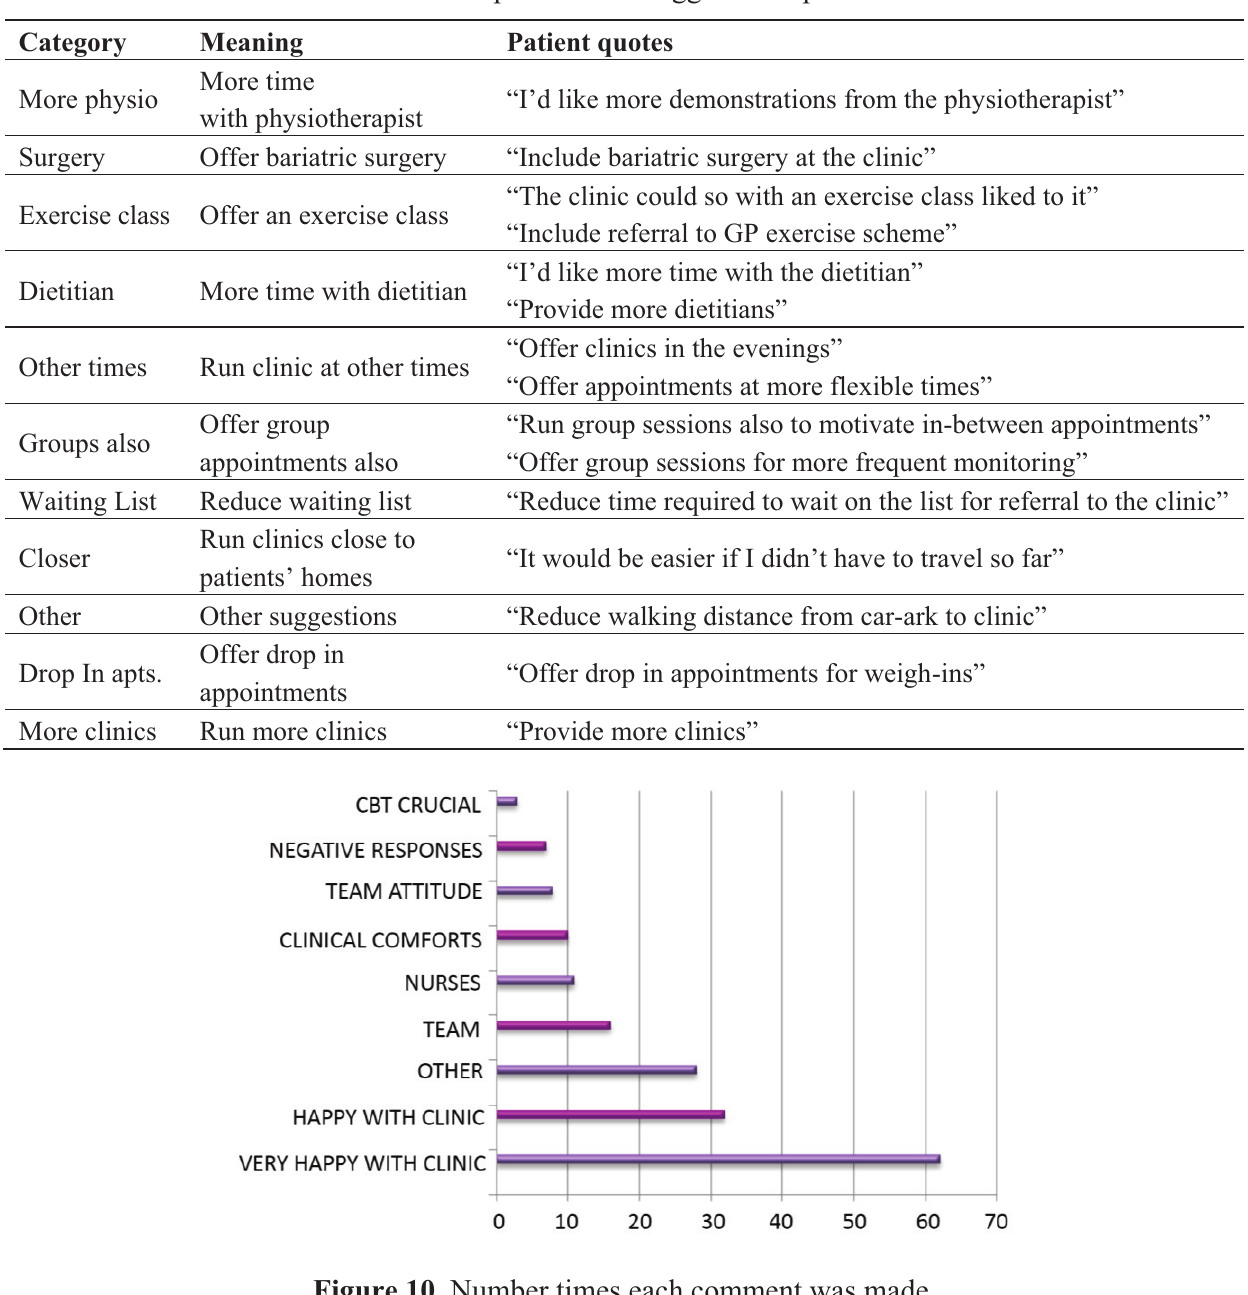
Table 19. Explanation of suggested improvements.